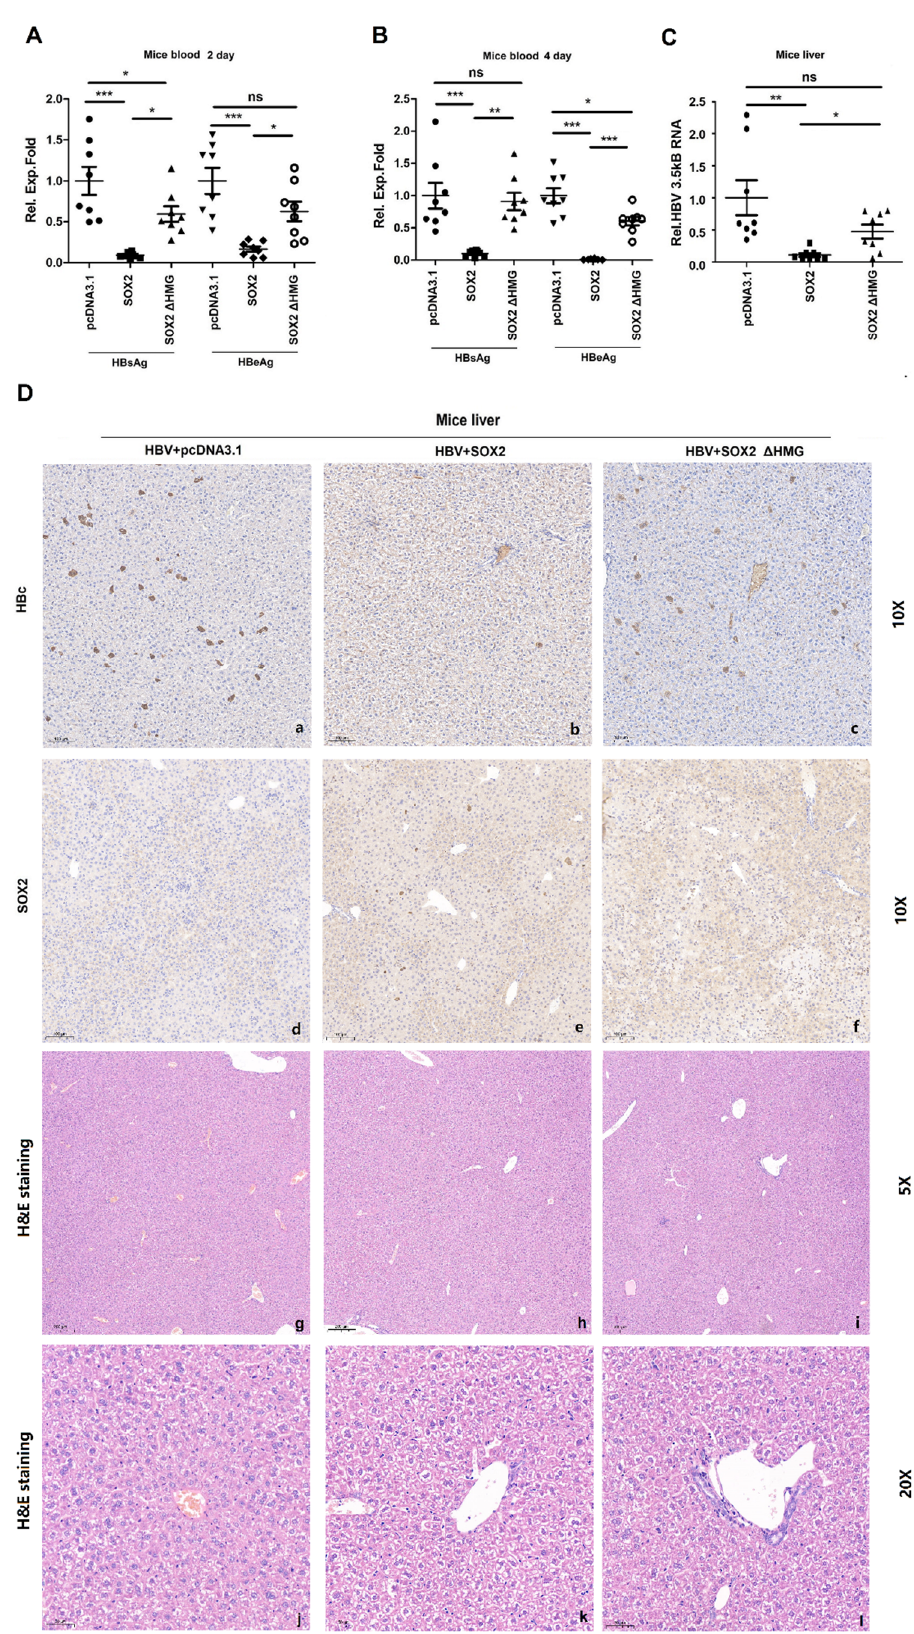
Figure 5. SOX2 suppresses HBV replication in BALB/c mice. ( A – D ) Three groups of BALB/c mice (5- week old, eight for each group) were co-injected with pAAV-HBV1.3 along with pcDNA3.1,